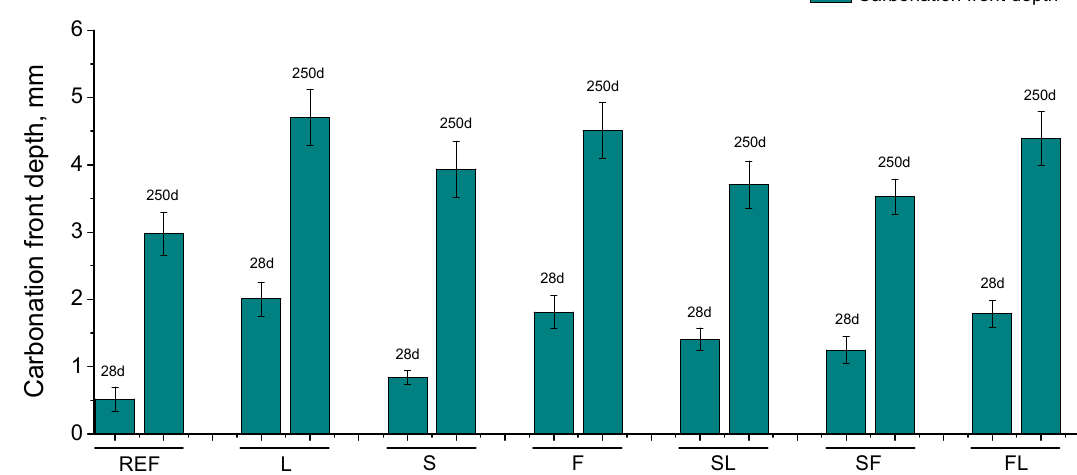
Figure 6. Carbonation front depths observed at 28 and 250 days for the characterized binders.